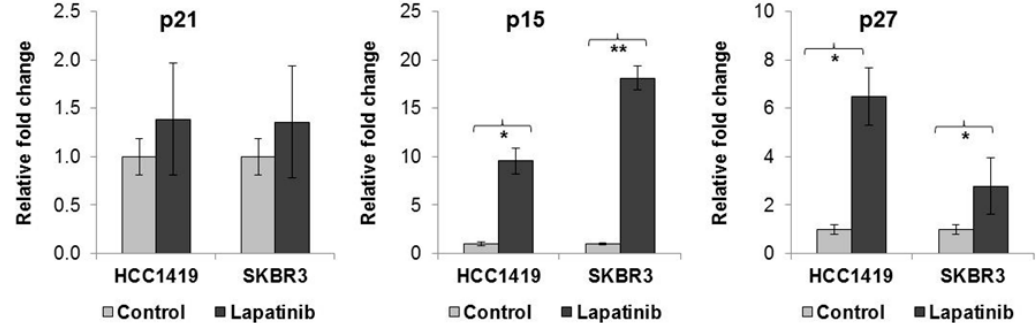
Figure 2. HCC1419 and SKBR3 cells were treated with 250 nM lapatinib for 1 and 2 weeks respectively, after which time RNA was isolated from control and treated cells. qRT-PCR was performed for senescence associated genes p15, p21 and p27 and the results are expressed as a fold-change in expression in lapatinib treated cells relative to untreated control cells for each cell line. * p < 0.005; ** p < 0.005 (error bars reflect n = 3, p -values calculated using Students t -test in excel).